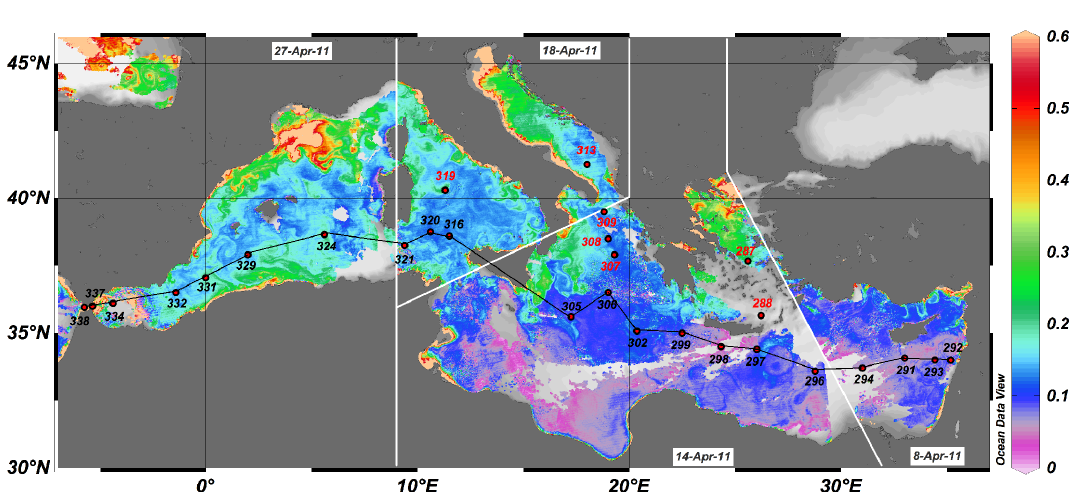
Figure 1. Sampling stations presented in this study collected during the M84-3 research cruise. A composite image is superimposed showing the surface chlorophyll concentration (mgm − 3 ) at an approximate date of the sampling period in the different basins. The transect shown in the following figures includes the stations labeled in